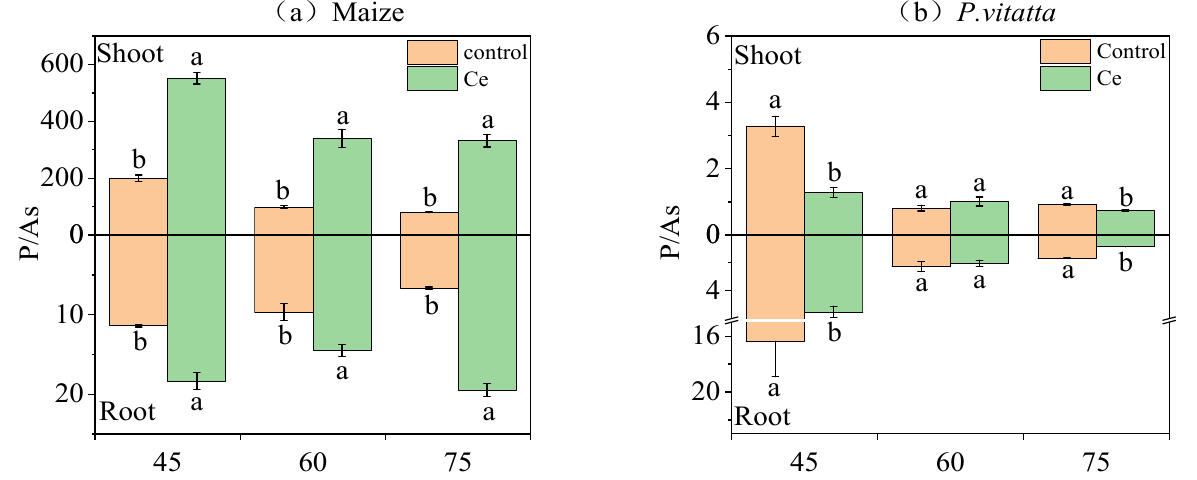
Figure 2. Effects of Ce colonization on the P/As of ( a ) maize and ( b ) P. vittata under arsenic stress. Ce, Claroideoglomus etunicatum ; P/As, phosphorus content/arsenic content. Lowercase letters “a” and “b” in the same group in the graph indicate significant differences between treatments ( p < 0.05).